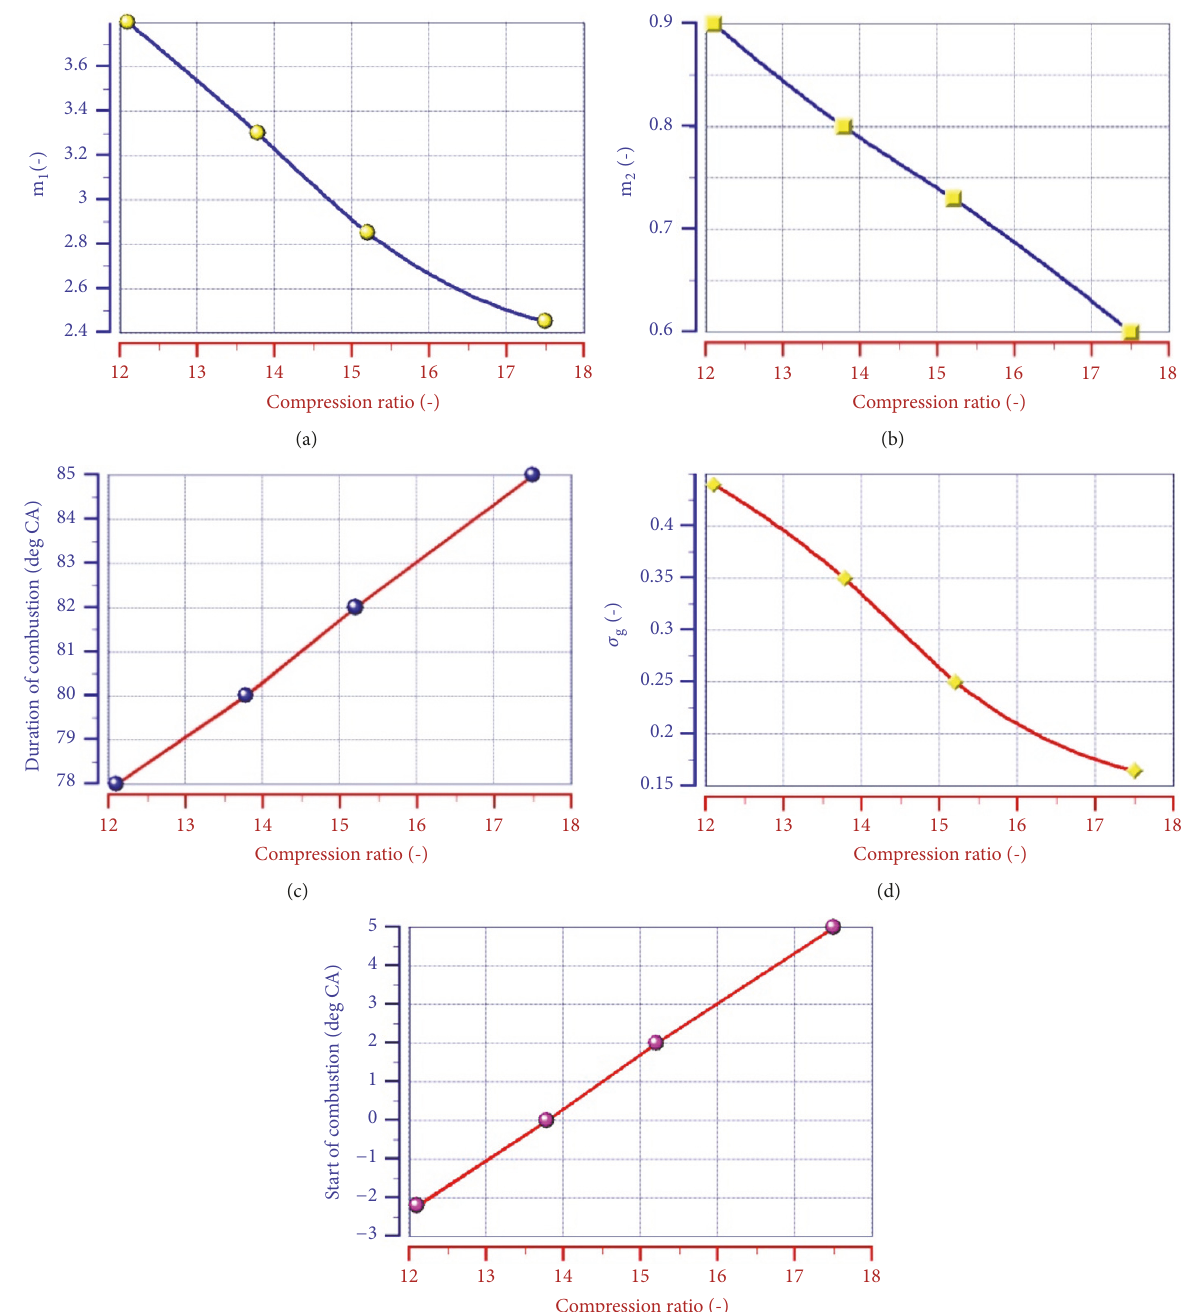
Figure 6: Model parameters variations as functions of the (CR) under n=1960 rpm, injection advance angle 18.5 (deg CA), and